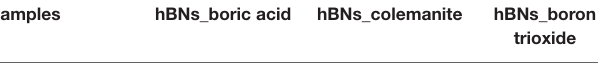
TABLE 2 | Zeta potential of synthesized hBNs.